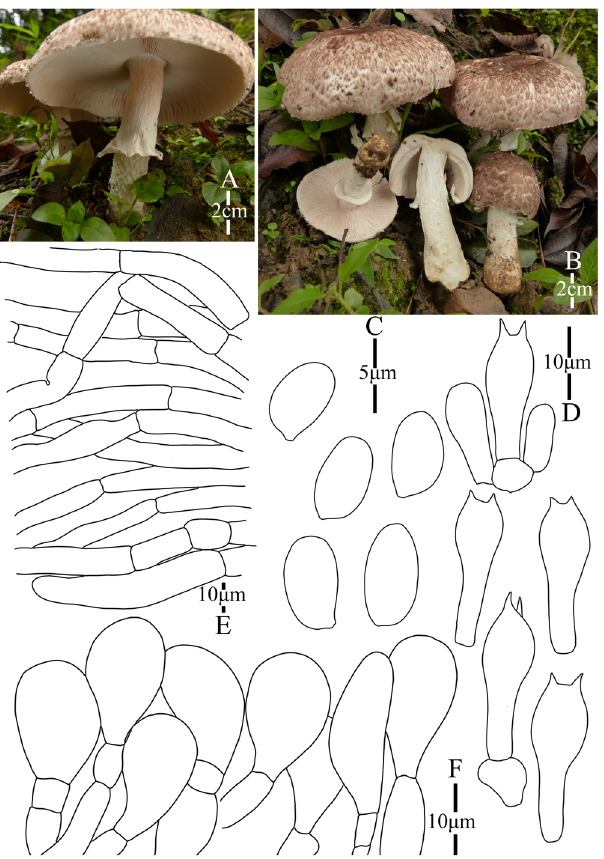
Figure 22. Morphology of Agaricus megalosporus ( A , B ): Basidiome in field ( ZRL2012199 ), ( C ): Basidiospores, ( D ): Basidia, ( E ): Pileipellis hyphae, and ( F ):